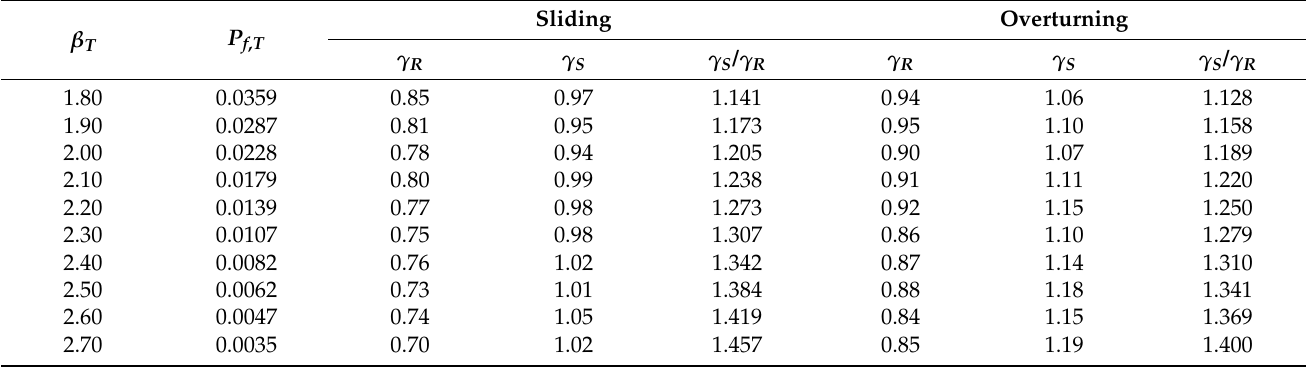
Table 3. Load resistance factors according to target reliability